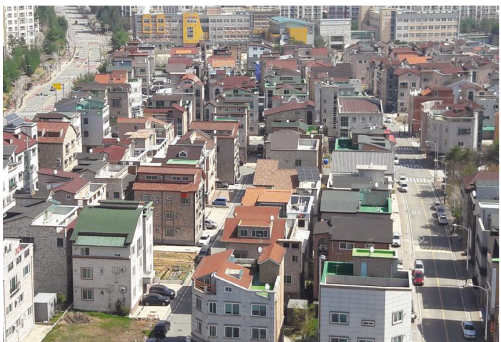
Figure 1: Small town in a suburban environment.